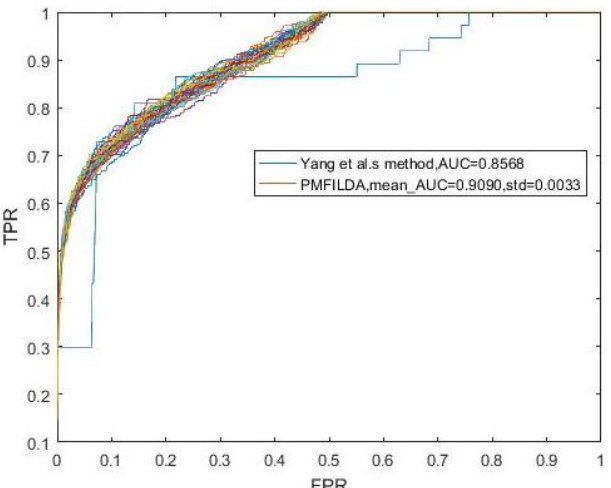
Figure 6. ROC curves and AUCs of PMFILDA and the method proposed by Yang et al.